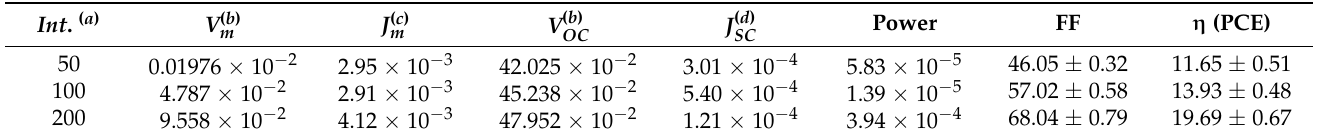
Table 6. Au/[ PoPDA/TiO 2 ] MNC /p-Si/Al polymer device performances under different illumination intensities P in